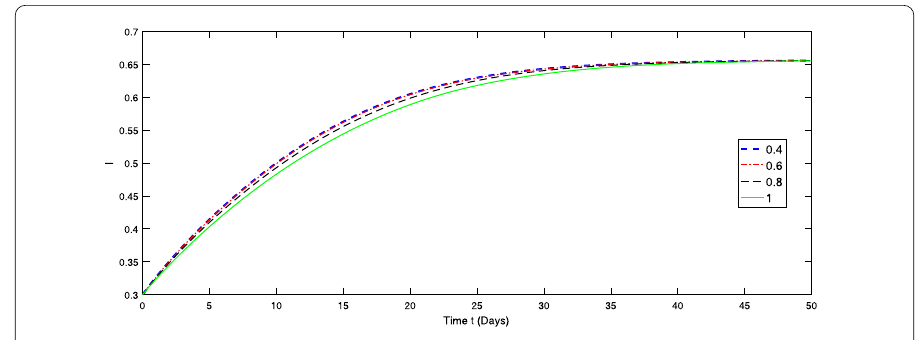
Figure 3 Graphical representation of numerical solution for specie I at various fractional orders of the considered model